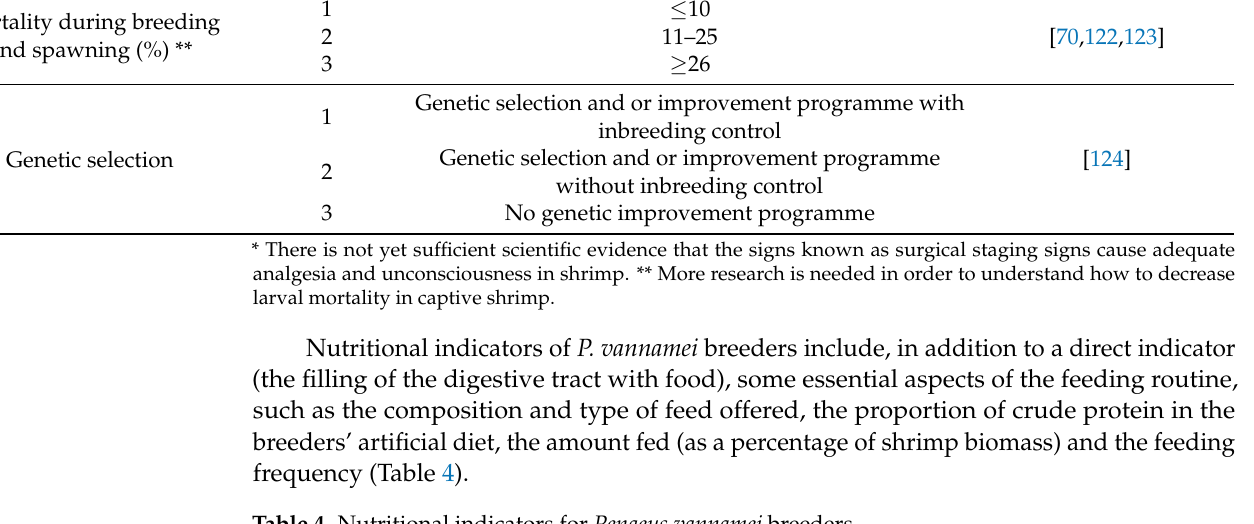
Table 4. Nutritional indicators for Penaeus vannamei breeders.